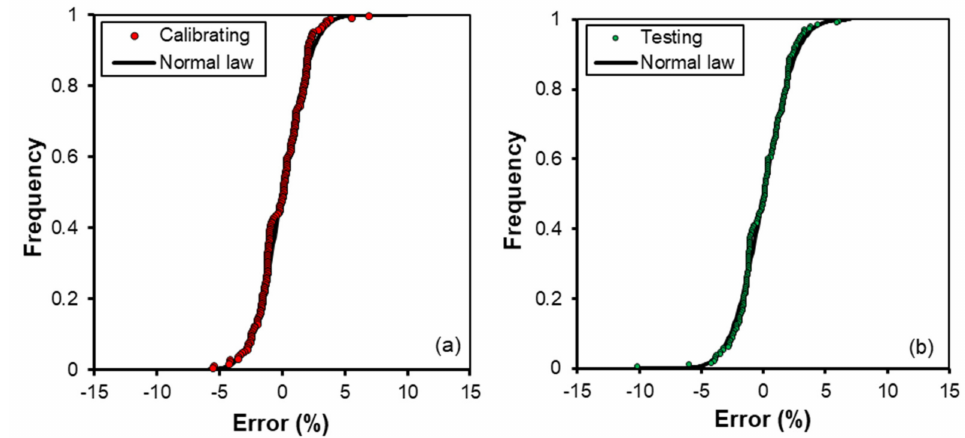
Figure 4. Frequency distribution of the errors in discharge estimate Er for calibrating ( a ) and testing ( b )